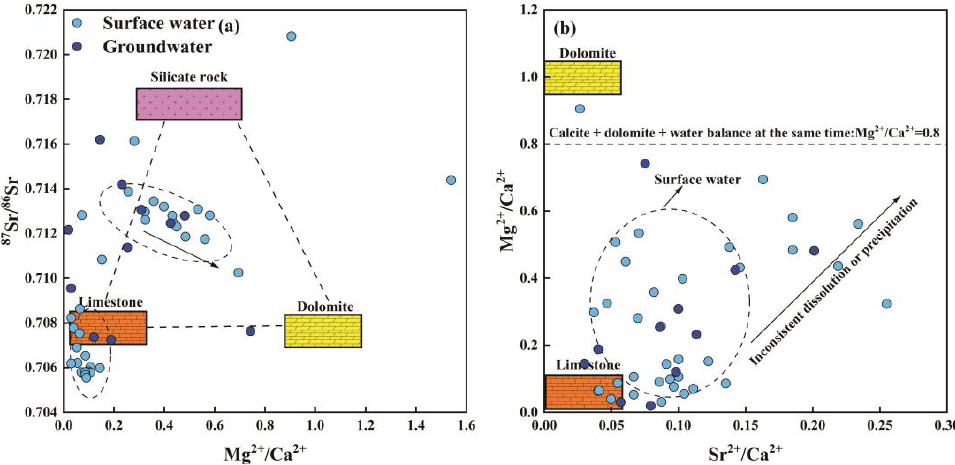
Figure 13. 87 Sr/ 86 Sr vs. Mg 2+ /Ca 2+ ( a ) and Mg 2+ /Ca 2+ vs. Sr 2+ /Ca 2+ ( b ) of surface water and groundwater samples in the lower reaches of the Yarlung Zangbo River. Data are from Table 1.